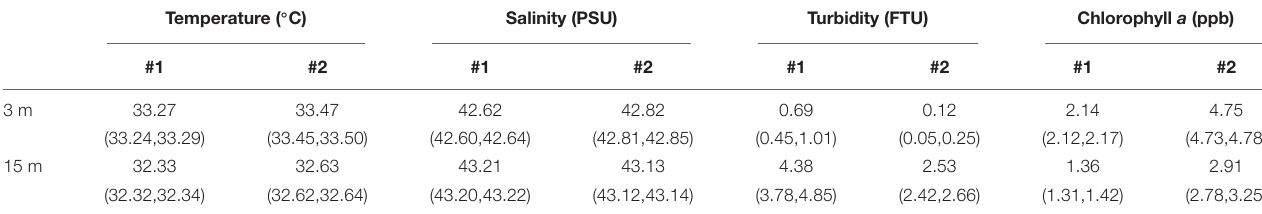
TABLE 2 | Averaged seawater properties and 95% CI measured by the micro-CTD at both locations. Temperature ( ◦ C) Salinity (PSU) Turbidity (FTU)